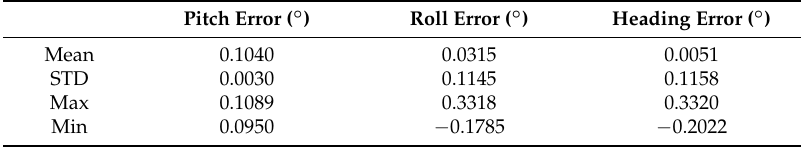
Figure 5. Attitude errors of the coarse alignment with the moderate sea condition. Table 2. Statistical analyses of the attitude errors with the moderate sea condition. Pitch Error ( ◦ ) Roll Error ( ◦ ) Heading Error ( ◦ )